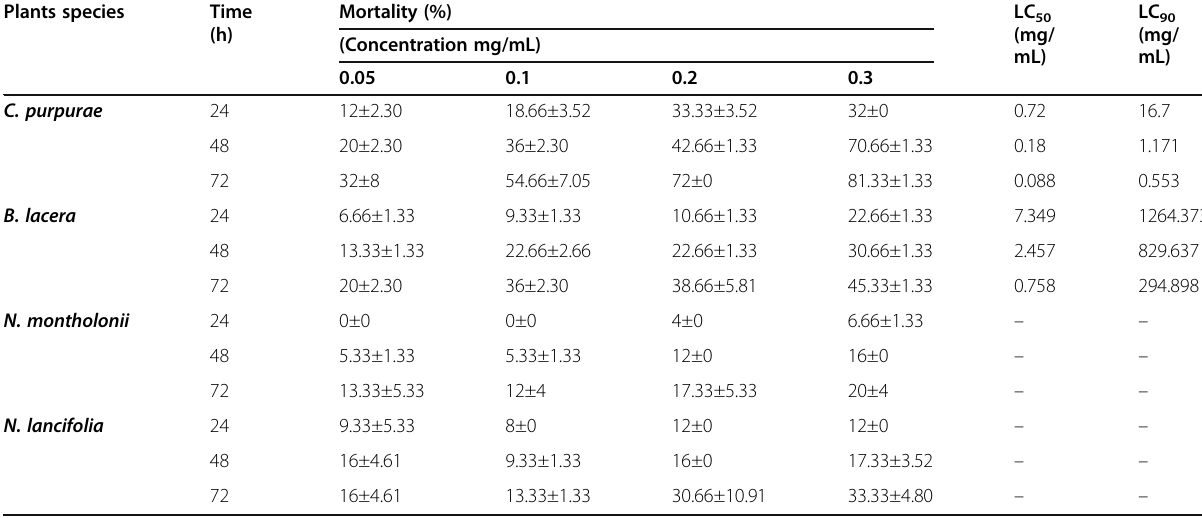
Table 1 Larvicidal activity of Cyathocline purpurae , Blumea lacera , Neanotis montholonii , and N. lancifolia extracts against the 3rd instar larvae of A. aegypti . LC 50 and LC 90 values are expressed in mg/mL Plants species Time Mortality (h)